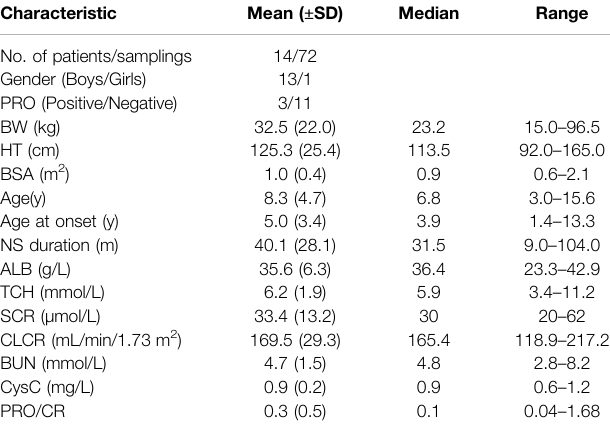
TABLE 1 | Characteristics of